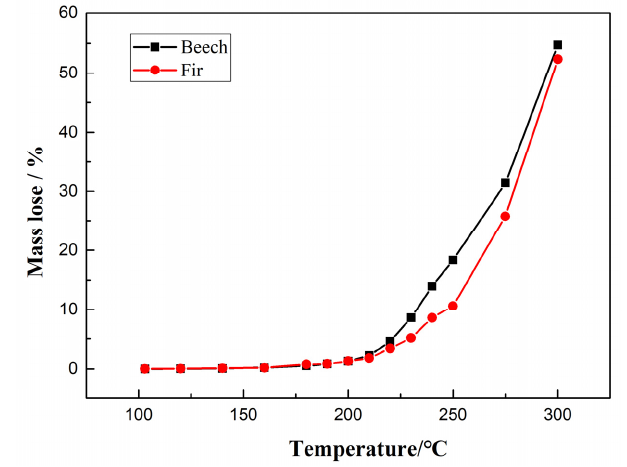
Figure 6. The mass loss of beech and fir at different temperatures.